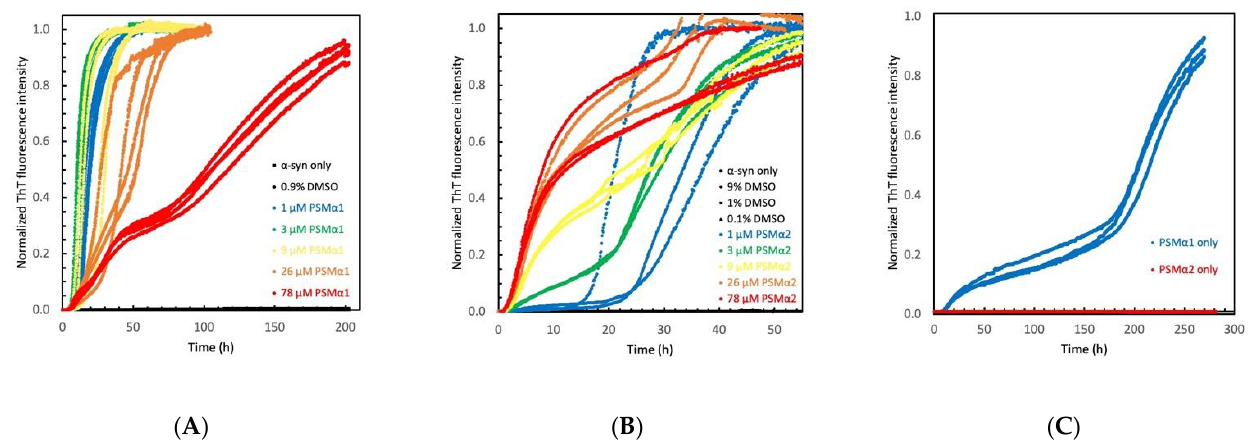
Figure 1. Aggregation of α -syn in the presence of PSM α peptides. ( A , B ) Normalized ThT fluorescence intensity as a function of time for 25 µ M α -syn in the presence of varying PSM α 1 ( A ) or PSM α 2 ( B ) concentrations as provided in the respective panel. ( C ) Control experiments with only 78 µ M PSM α 1 (blue) or 78 µ M PSM α 2(red). All experiments started from monomers and were performed in 10 mM Tris, 50 mM NaCl, pH 7.6 at 37 °C under quiescent conditions.